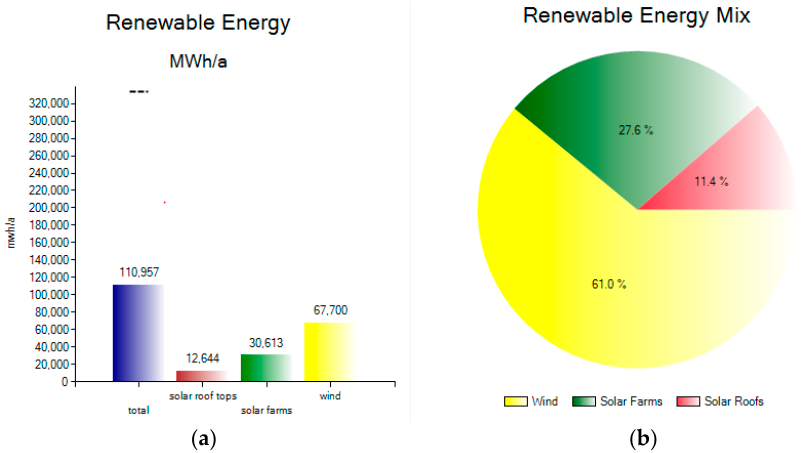
Figure 2. Charts visualizing the outcome indicators of the mapping sessions: ( a ) bar chart showing total renewable energy in MWh per type of renewable energy resulting from the current allocations; ( b ) the resulting mix of renewable energy.